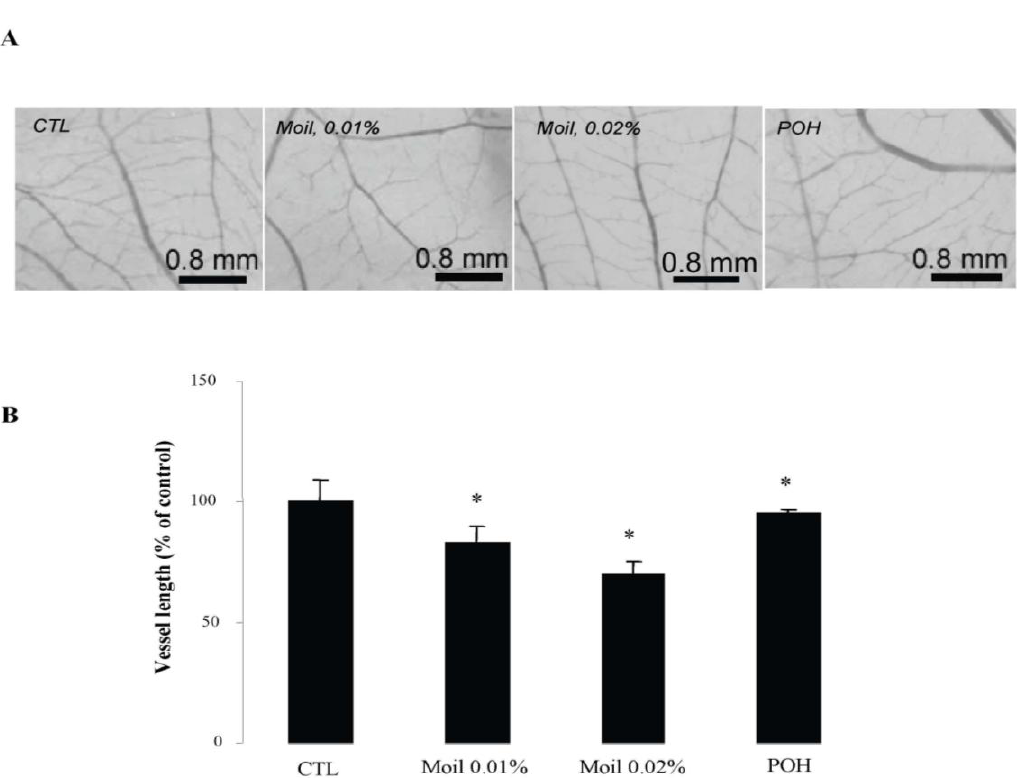
Figure 3. Mastic oil attenuates tumor-related angiogenesis. Tumor cells pre-treated with vehicle (CTL), Moil (0.01-0.02 % v/v) or POH (0.5 mM) for 2 h were applied onto the CAM and further incubated for 48 h at 37 o C in the presence of test agents. ( A ) Representative photographs of vessel networks in the CAM; ( B ) Graphs from image analysis of vessel network length (mean % of control ± SEM, n = 30, *P<0.05 from